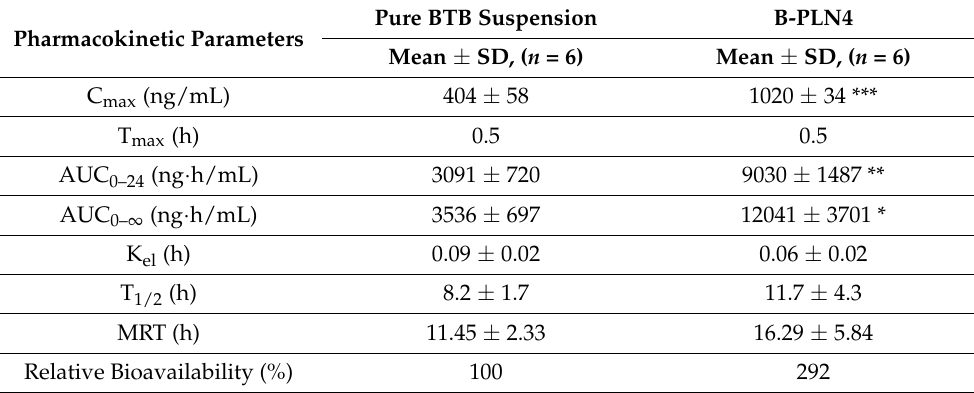
Table 2. Pharmacokinetic Parameters after a single oral dose of pure BTB suspension and B-PLN4 administration (1 mg/kg in